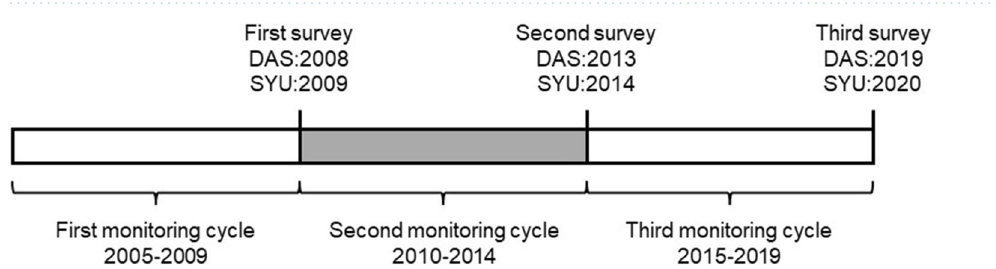
Figure 7. The definition of each survey year and the monitoring cycles in this